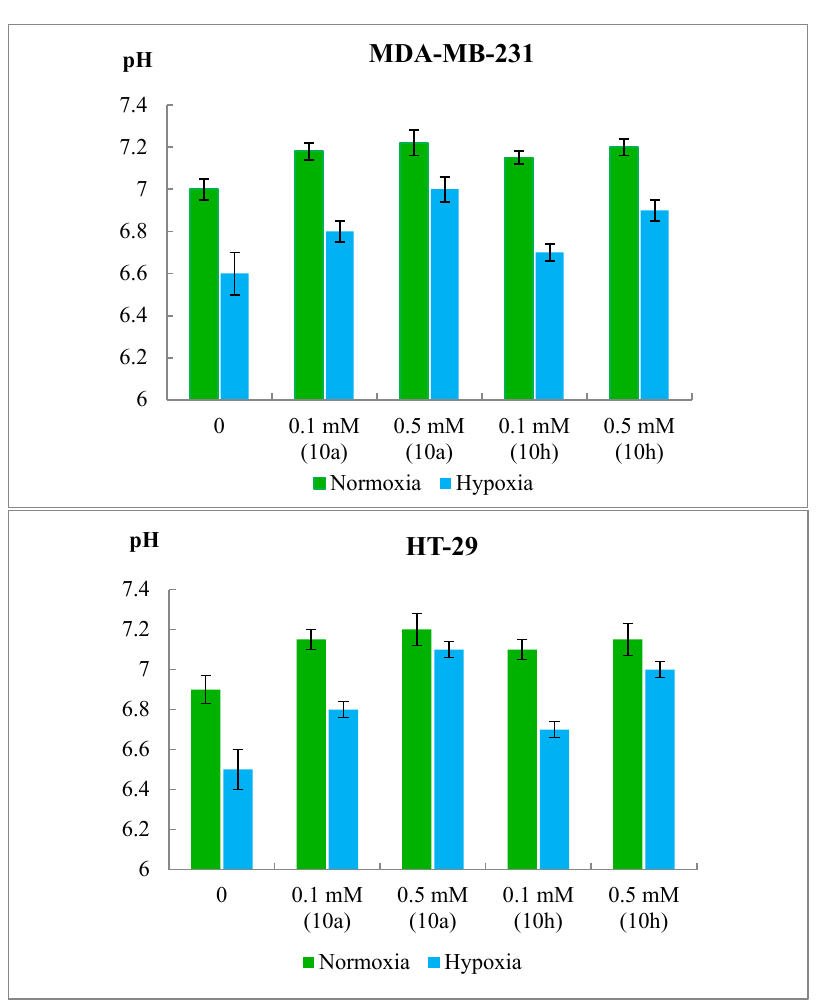
Figure 3. Extracellular pH measurement after 48 h of HT-29 and MDA-MB-231 cancer cells in normoxia and hypoxia upon treatment with compound 10a and 10h (0.1 and 0.5 mM).